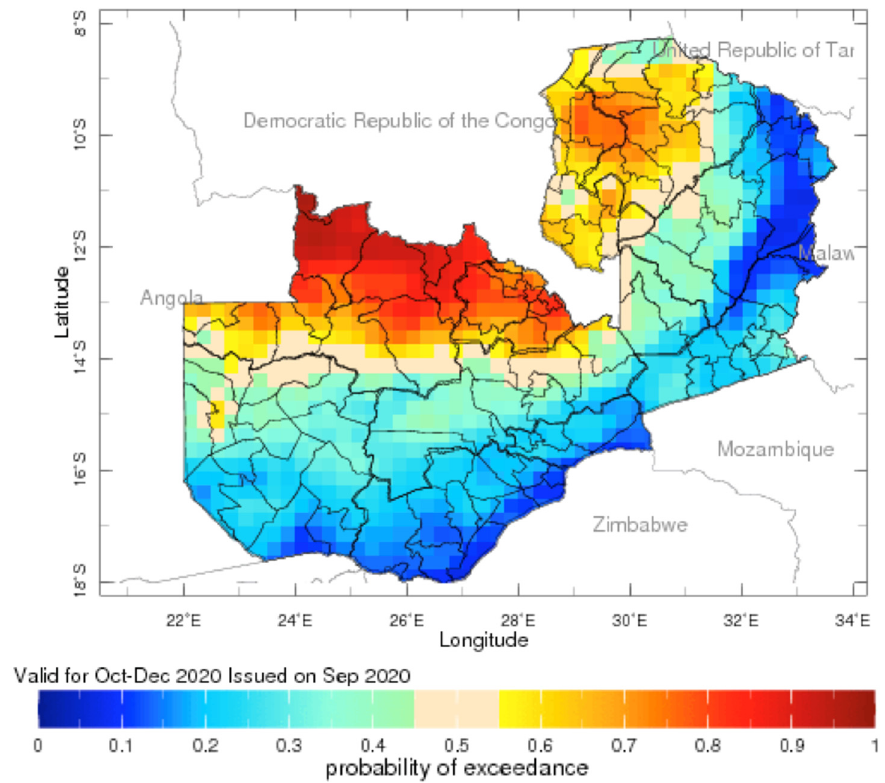
Figure 9. Probability that the October-November-December 2020 seasonal rainfall total over Zambia, forecasted in September 2020, will exceed 350 mm.